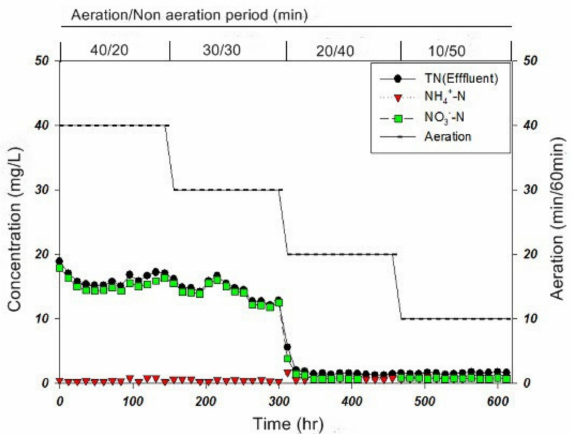
Figure 8. T-N concentration in MBR with intermittent aeration.